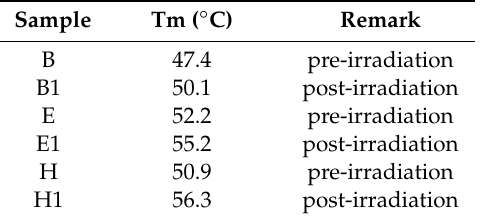
Figure 12. Differential scanning calorimetry (DSC) curves of P(LA-CL) composite materials (B, E, and H without irradiation and B1, E1, and H1 with irradiation). Table 4. Melting temperatures of P(LA-CL) composite materials.